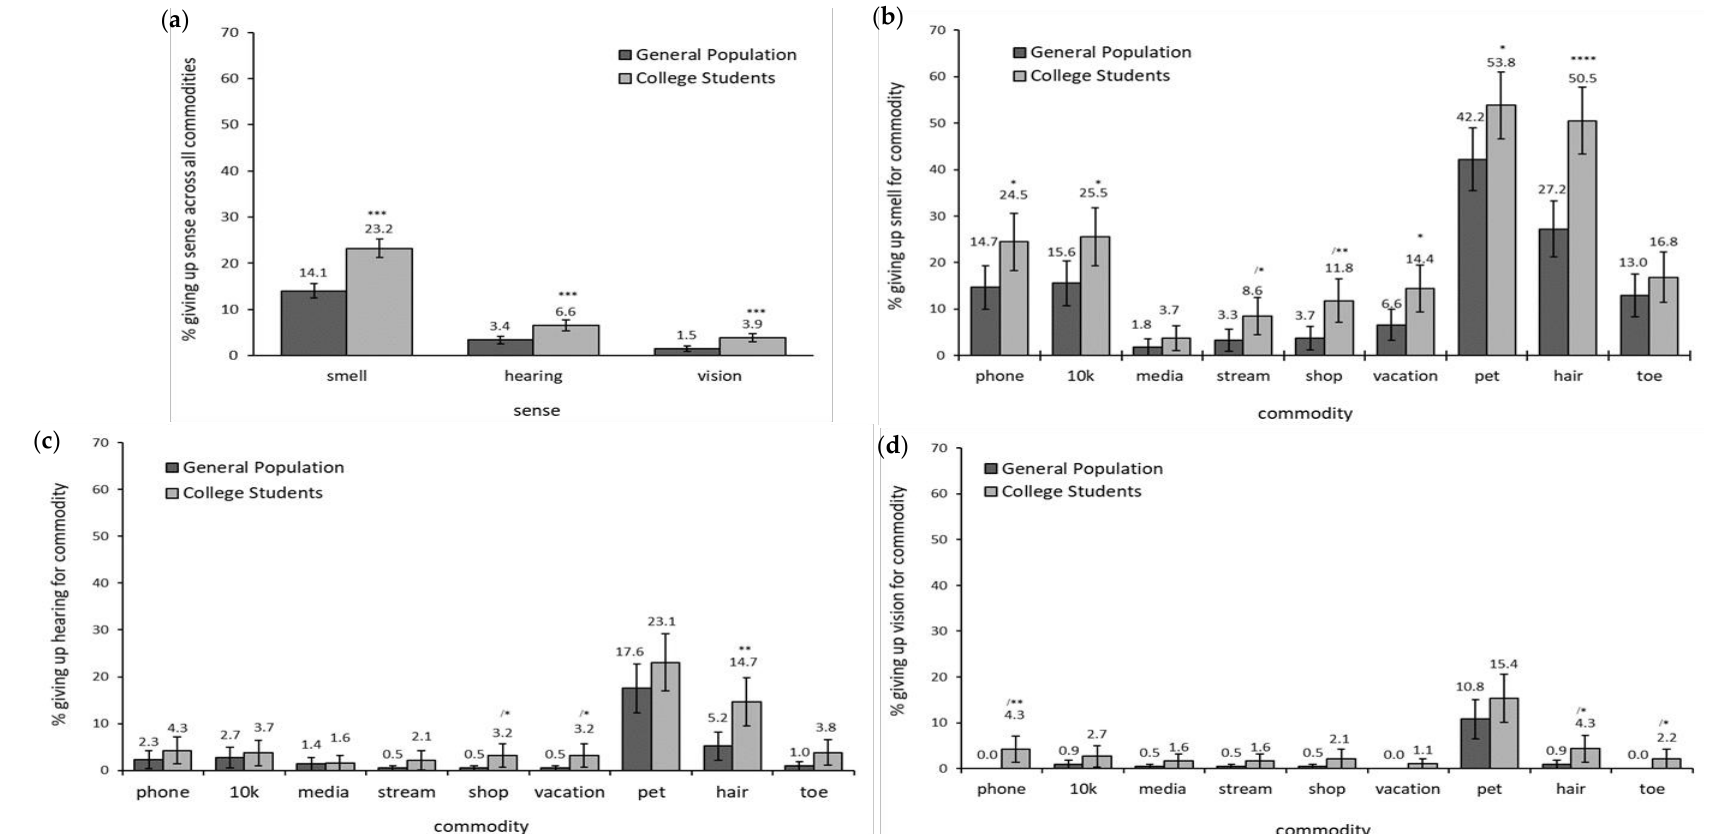
Figure 2. Willingness to give up each sense between the General Population and College Student groups ( a ) by responses collapsed over all commodities for each sense ( b ) by responses to each commodity compared to smell, ( c ) by responses to each commodity compared to smell, ( d ) by responses to each commodity compared to vision. Note: significance indicated by * p < 0.05, ** p < 0.01, *** p < 0.001, **** p < 0.0001; / indicates caution on interpretation due to low number of responses of one of the comparators (for details see Methods section).